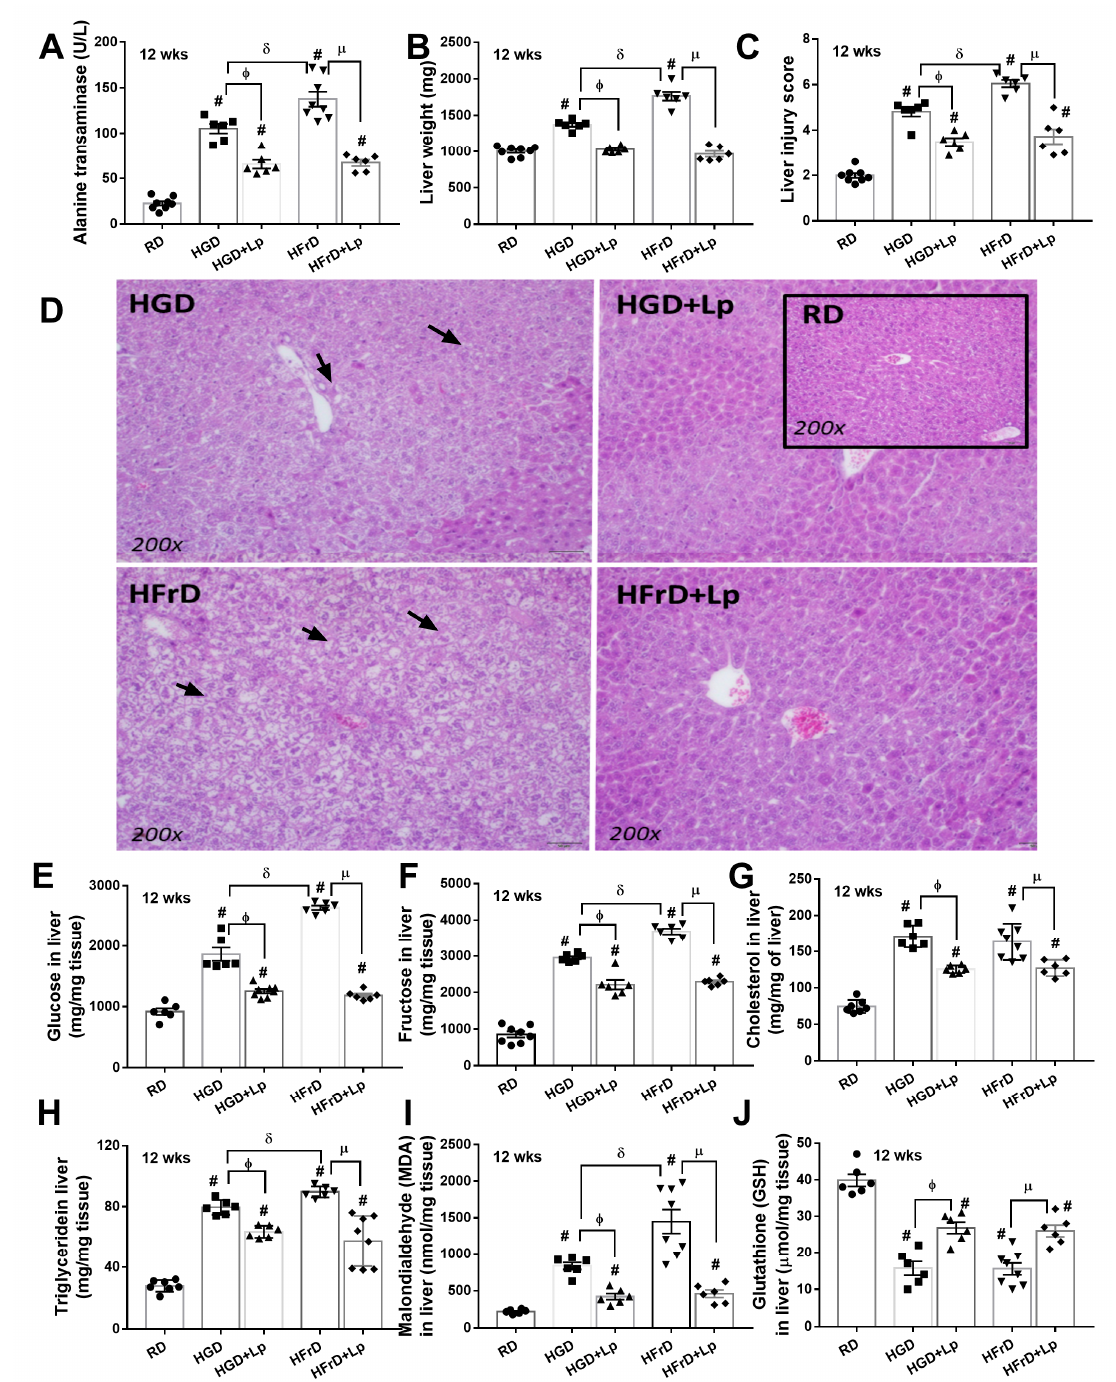
Figure 3. Characteristics of liver injury in mice with a regular diet (RD) or a high-glucose diet (HGD) or fructose diet (HFrD) with or without Lactiplantibacillus plantarum (Lp) are demonstrated as determined by alanine ( A ), liver weight ( B ), liver injury score with representative histological pictures ( C , D ), liver (glucose, fructose, cholesterol and triglyceride) ( E – H ), oxidative stress in the liver (malondialdehyde; MDA) ( I ), and an antioxidant molecule in the liver (glutathione; GSH) ( J ) are demonstrated (n = 6–8/group). #, p < 0.05 vs. RD; φ , p < 0.05 HGD vs. HGD+Lp; µ , p < 0.05 HFrD vs. HFrD+Lp; δ , p < 0.05 HGD vs. HFrD; Arrows indicate hepatocytes with fat accumulation.